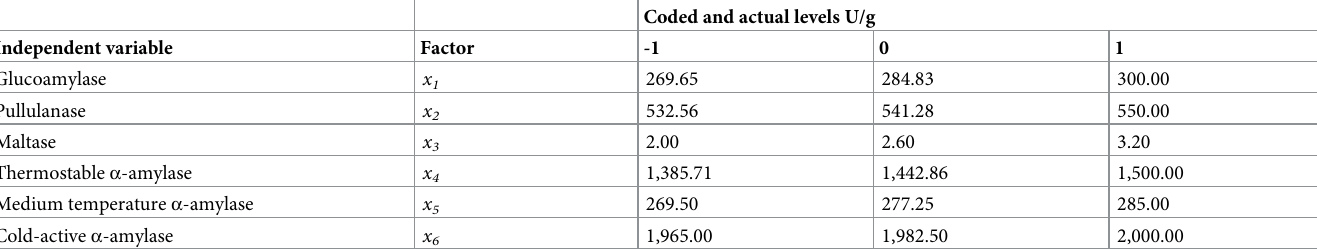
Table 3. Independent variables and their ranges used for zymogram optimization in the Box Behnken